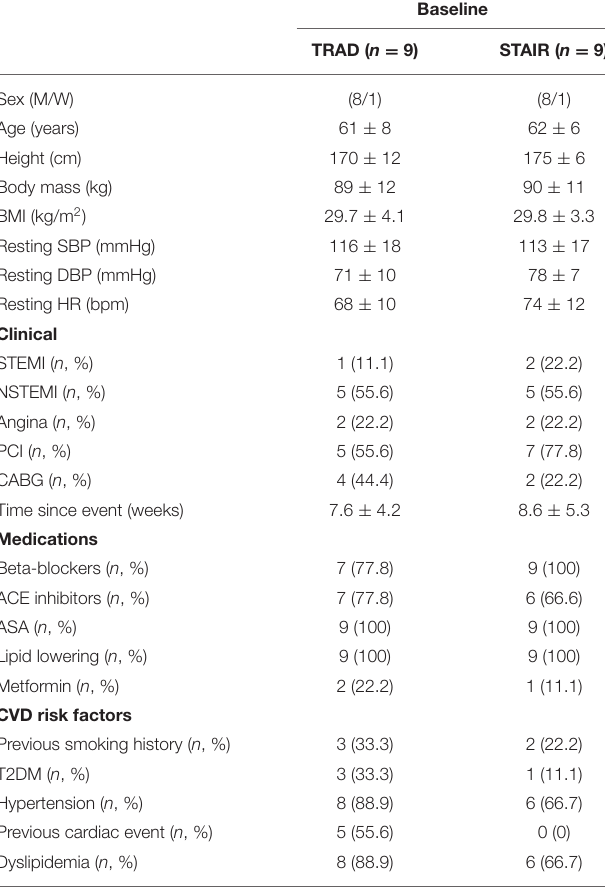
TABLE 1 | Participant